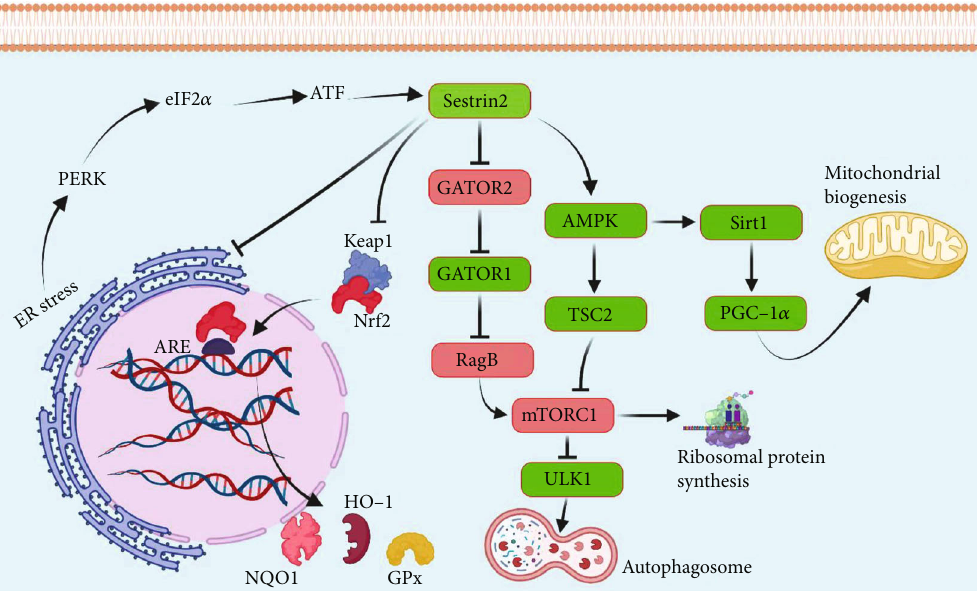
Figure 1: The involvement of Sestrin2 in cellular signaling. Sestrin2 is a central regulator of cellular homeostasis. Sestrin2 can liberate Nrf2 from Keap-1 sequestration and potentiate antioxidant defense. Sestrin2 can also inhibit mTORC1 through AMPK/TSC2 or GATOR2/ GATOR1/RagB pathways. mTORC1 inhibition by Sestrin2 blocks ribosomal protein synthesis but activates ULK-1-mediated autophagy. Inhibition of ribosomal protein synthesis and activation of autophagy can prevent ER stress. However, ER stress can upregulate Sestrin2 through PERK/eIF2 α /ATF pathway. Furthermore, activation of AMPK/Sirt1/PGC-1 α pathway by Sestrin2 is deeply involved in mitochondrial